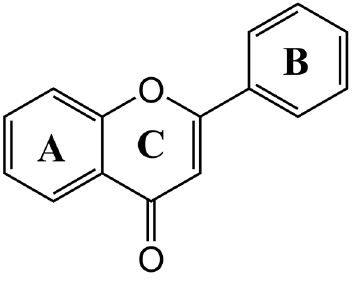
Figure 2. Backbone structure of flavones. Two benzene rings (A and B) linked through a heterocyclic pyrane ring (C).